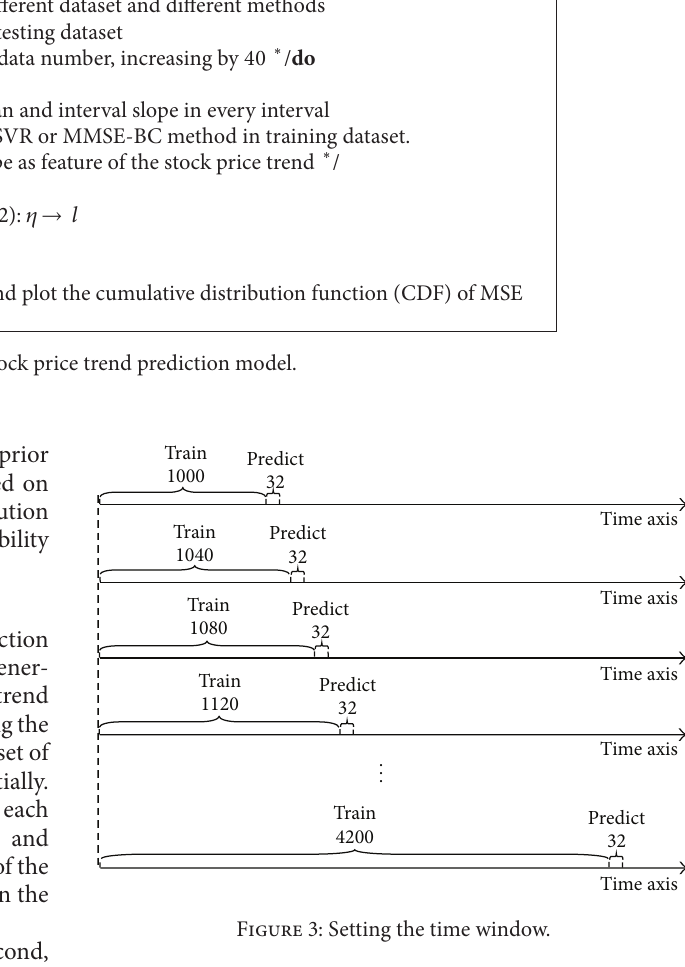
Figure 3: Setting the time